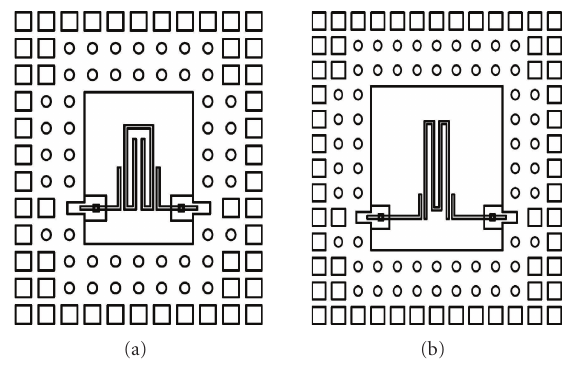
Figure 20: (a) Folded resonator, (b) W -shape resonator.